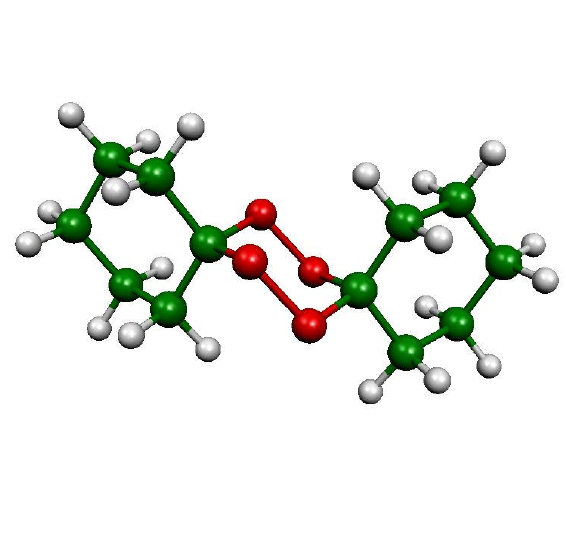
Figure 1. Structure of